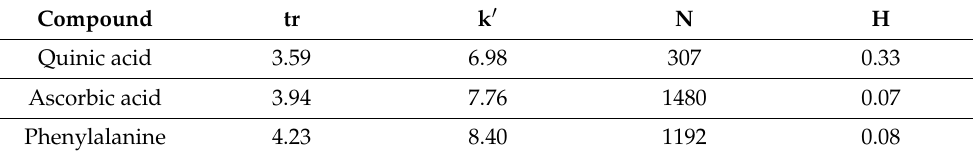
Table A1. Chromatographic parameters associated with the peaks.